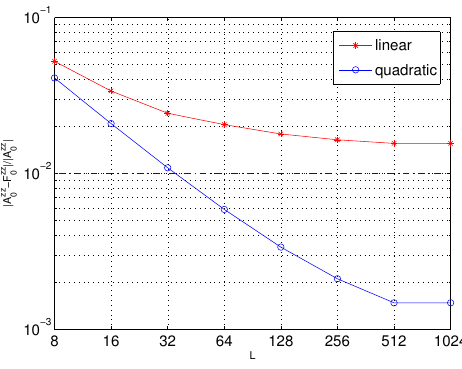
Figure 5. TEST 1 on hexahedron Mesh1: relative errors at the origin, using linear and quadratic elements. The dashed line is the target accuracy defined by Eq. (3.1).